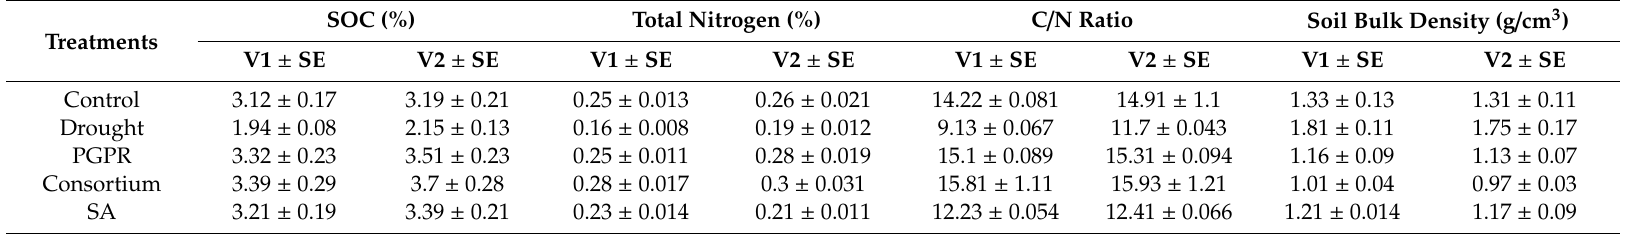
Table 8. Soil organic carbon (SOC), total nitrogen (TN) and bulk density of rhizosphere soil.